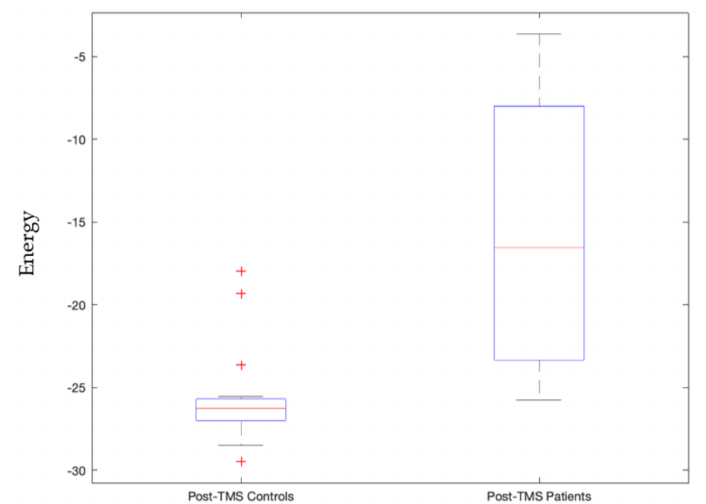
Figure 7. Energy values of controls significantly differed from patients during post-TMS subthreshold pulse stimulation condition with a p -value = 0.00014 for the inactive salience network energy state. TMS subthreshold pulse was administered at the